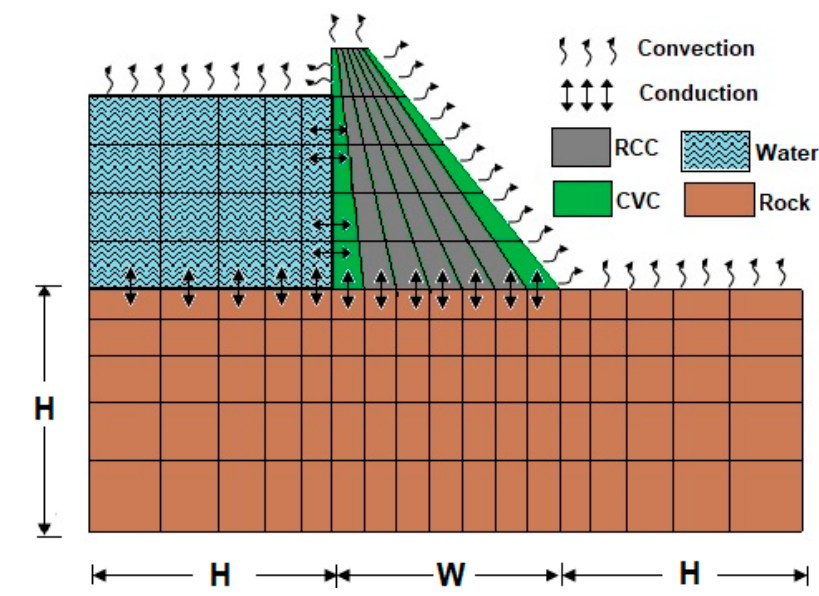
Figure 3. Finite element modeling of Al-Khanaq RCC dam.